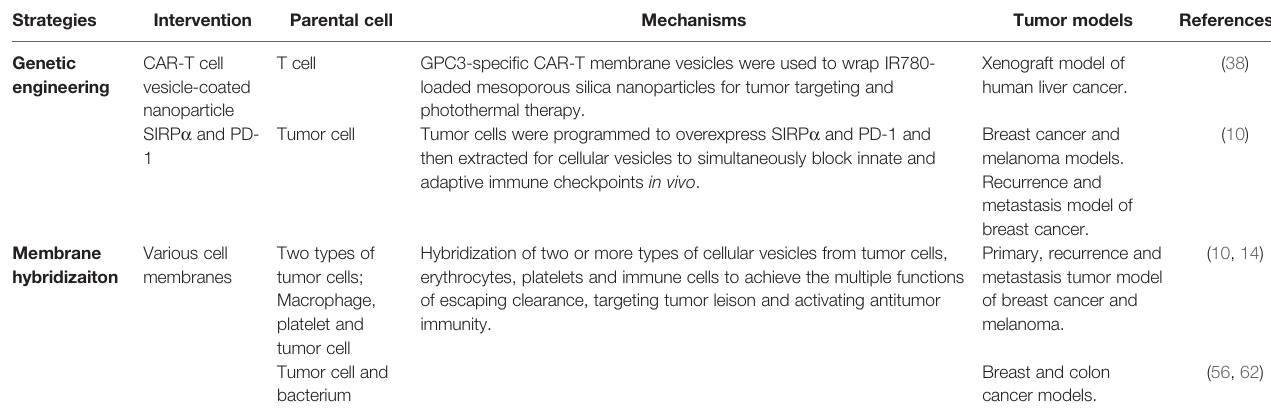
TABLE 1 | Applications of cellular vesicles in cancer